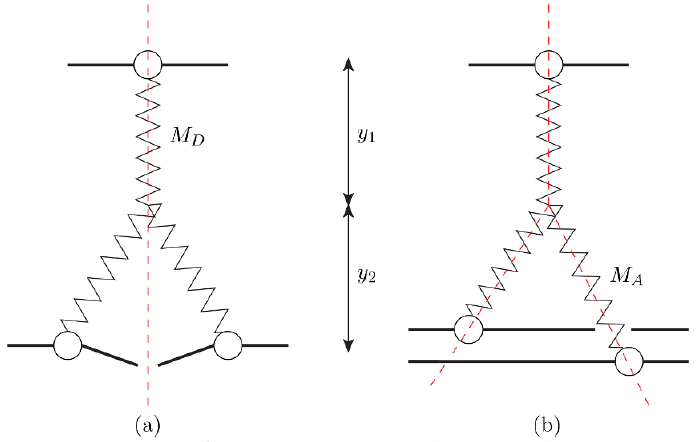
Figure 22 . Pomeron diagrams with cuts indicated for (a) single di(cid:11)ractive excitation in proton- proton and (b) doubly absorptive proton-deuteron